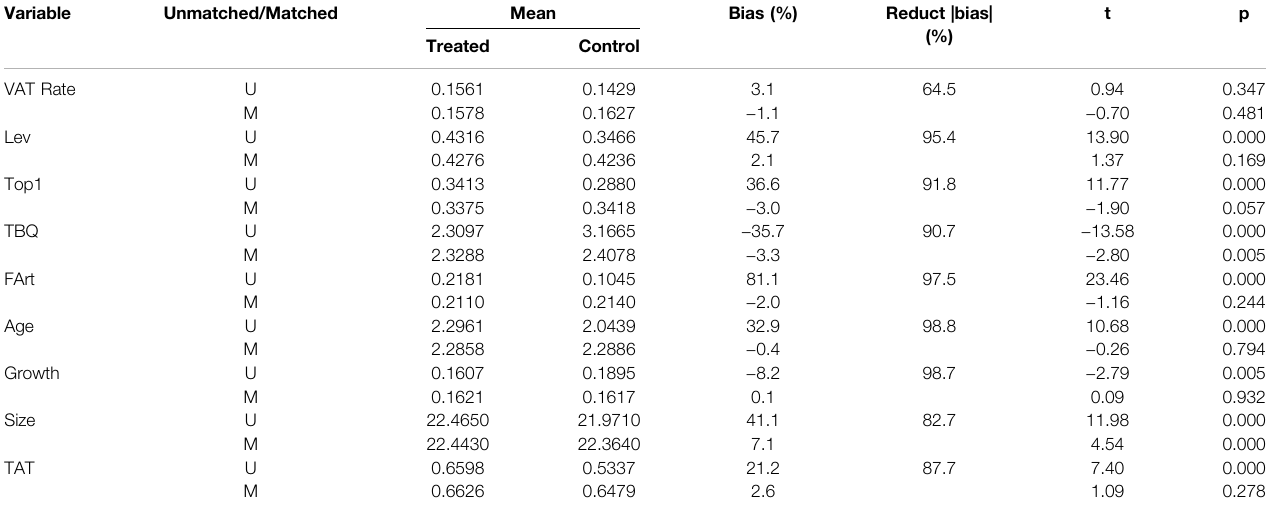
TABLE 2 | Propensity score matching results. Variable Unmatched/Matched